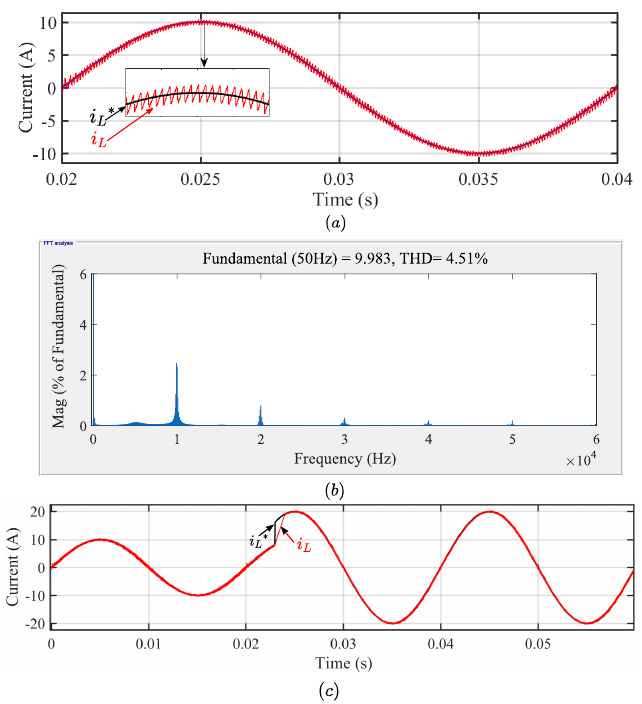
Figure 20. Waveforms obtained by simulating the proposed method with the parameters in [28]. ( a ) Steady state performance of the proposed method. ( b ) Frequency spectrum. ( c ) Dynamic